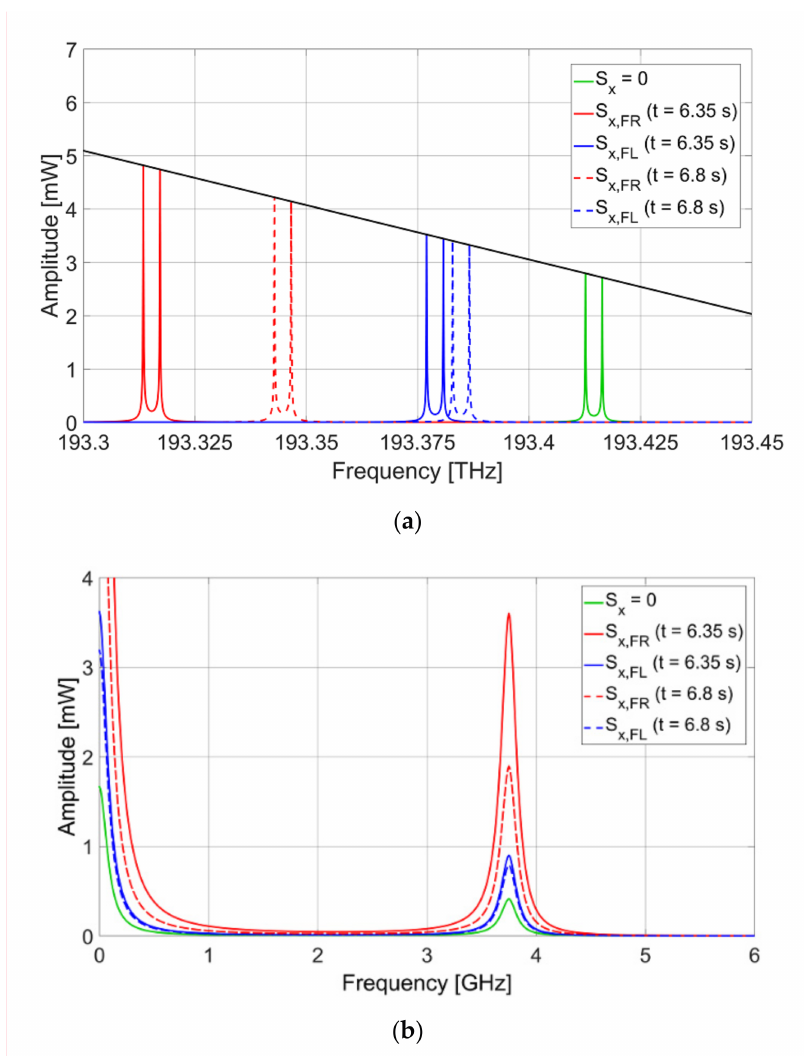
Figure 10. ( a ) AFBS spectra and the optical filter frequency response for five cases of applied strain: AFBS without strain (green line), front right bearing at t = 6.35 s (red solid line), front right bearing at t = 6.8 s (red dashed line), front left bearing at t = 6.35 s (blue solid line), and front left bearing at t = 6.8 s (blue dashed line); ( b ) Corresponding spectra of electrical signal at the